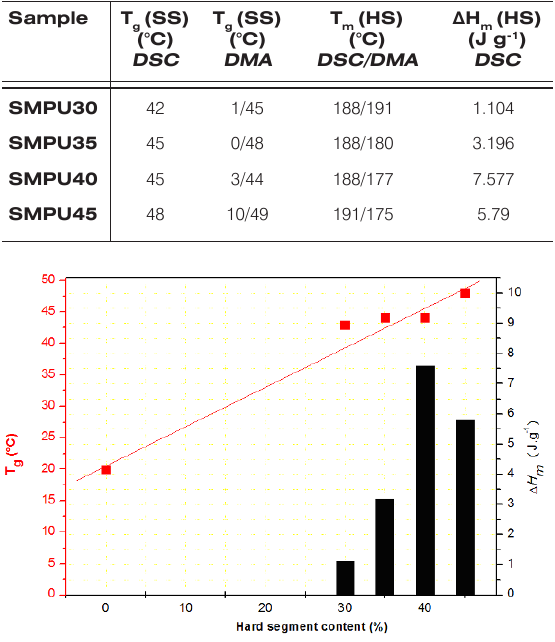
Figure 3. Dependence of T